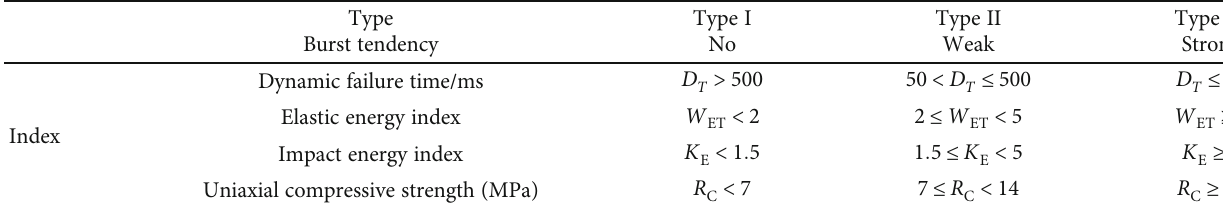
Table 4: Classi fi cation of burst tendency of coal.